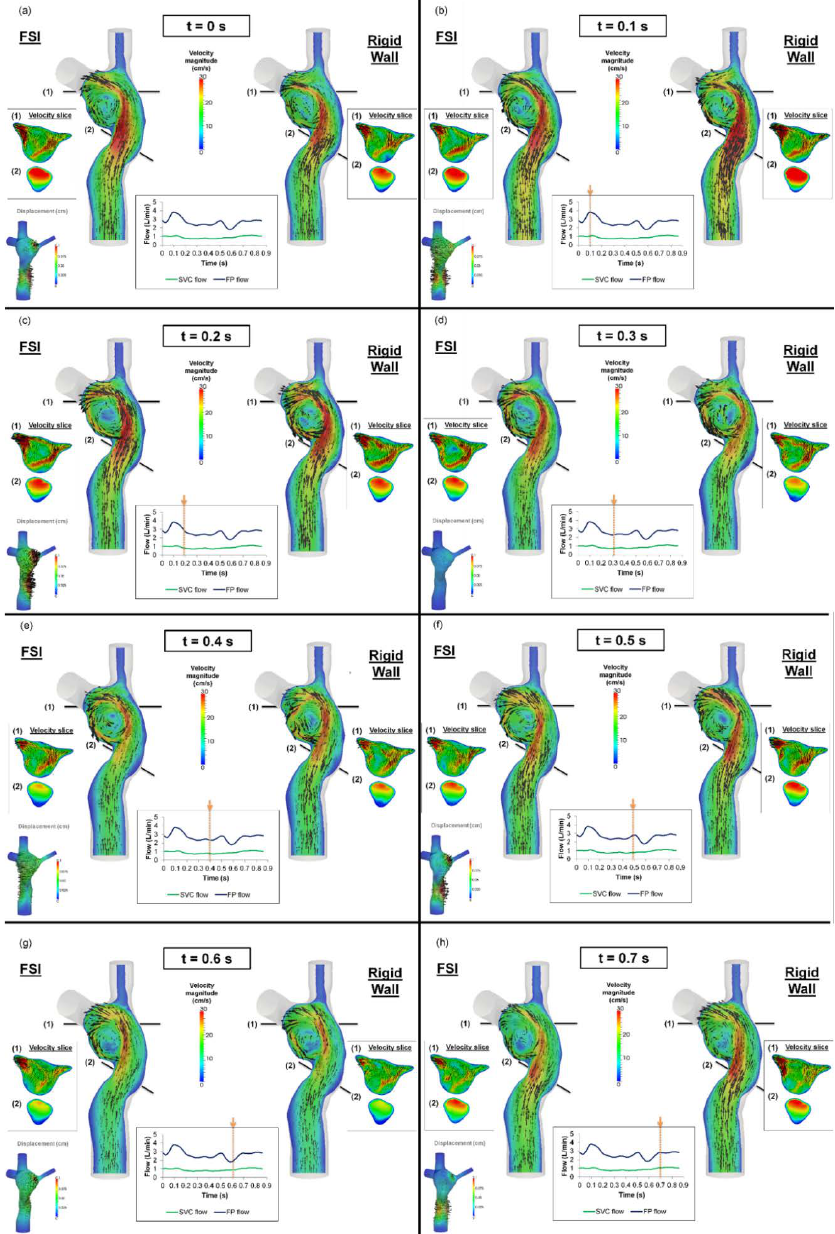
Figure 8. Flow field of the TCPC from the fluid-structure interaction (FSI) and rigid wall simulations ( a – h ) from t = 0 s to t = 0.7 s, at a 0.1 s interval. The displacement field of the FSI simulation at the corresponding time point is shown in the bottom-left corner. FP: Fontan pathway, SVC: superior vena cava, TCPC: total cavopulmonary connection.